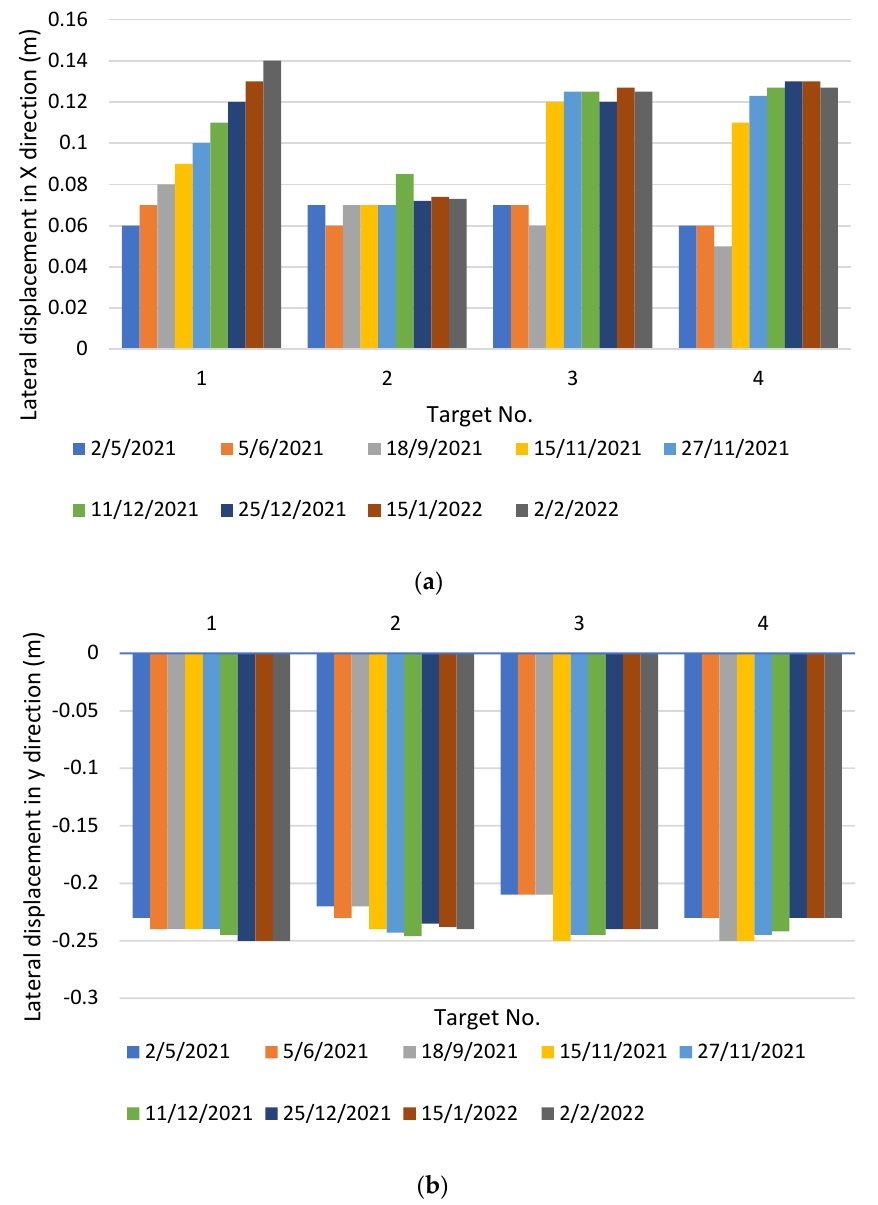
-0.3-0.25-0.2-0.15-0.1-0.050 Figure 4. Target points movements with respect to time: ( a ) in x direction and ( b ) in y direction. As shown in Figure 4, immediately prior to the micropiling process, on 27 November 2021, the building was tilted 24.5 cm toward the south and 12.5 cm toward the east. This corresponded to inclination ratios of around 1H:113V toward the south and 1H:222V toward the east. Moreover, rotations of the east and west sides of the raft were monitored over time. These rotations, calculated by using Equations (1) and (2), are presented in Figure 5. S se − S ne Rotation of the east side of the raft = (1) D se _ ne S sw − S nw Rotation of the west side of the raft = D sw _ nw Figure 5. Rotation of east and west sides with respect to time. 3. Retrofitting the Foundation System 3.1. Preliminary Analysis Despite the recommendation of a geotechnical consultant to use deep foundations, the tower was originally constructed with a foundation consisting of a raft with an area of 389 m 2 positioned 2.6 m below the ground surface. Without considering the tilt, a 3D finite element model of the building was developed by using a commercially available software package (ETABS). Based on this structural model, the total load on the tower was estimated to be 49,664 kN, taking into account the live load, dead load, and floor coverings. It was found that there was a critical eccentricity of at least −4 0 cm in the y - direction between the centroid of the total tower loads and the centroid of the foundations. This eccentricity, in conjunction with the weak soil conditions, was presumed to be the primary factor leading to the tilt observed in the building.